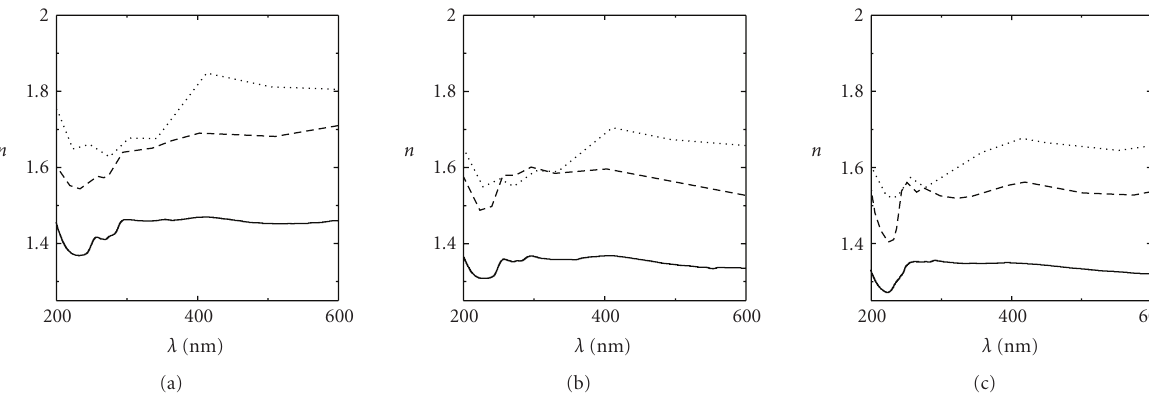
Figure 6: Spectral distribution of refractive index ( n ) for (a) pure PMMA, (b) a blend of (50/50 PMMA/PVAc), and (c) pure PVAc before (—) and after exposure to filtered (- - -) and UV radiation ( ... ) for 24